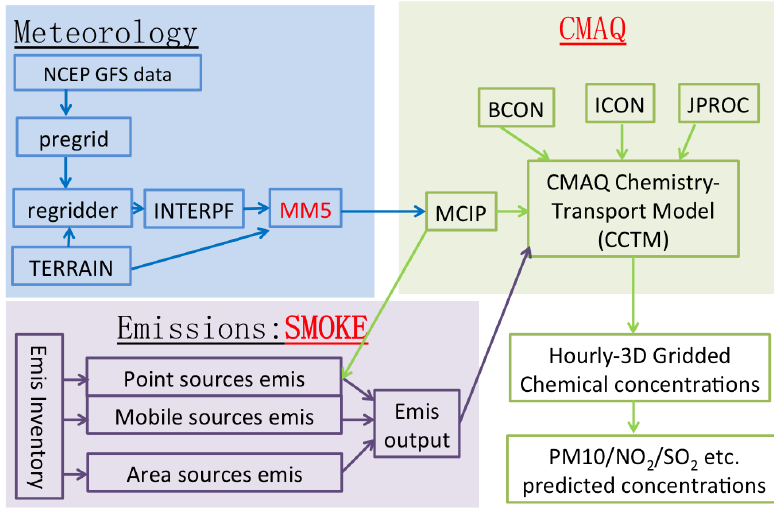
Figure 1. The framework of the MM5-SMOKE-CMAQ forecast system in Beijing.